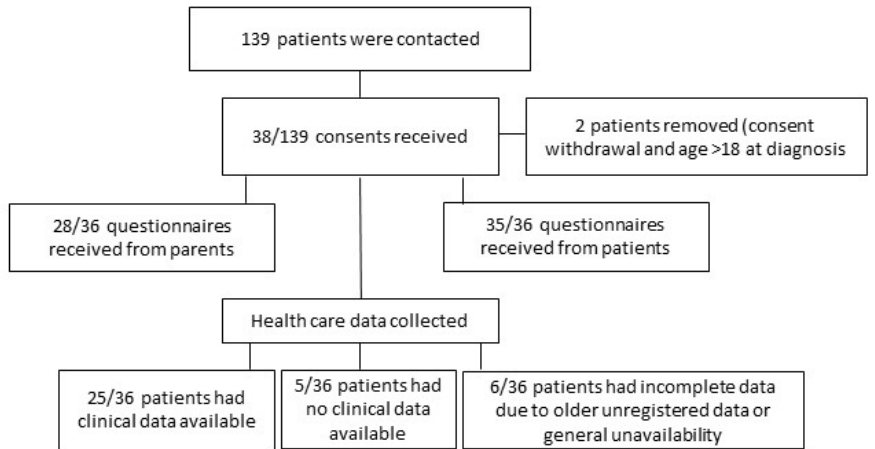
Figure 1. Study participation and the responses received.